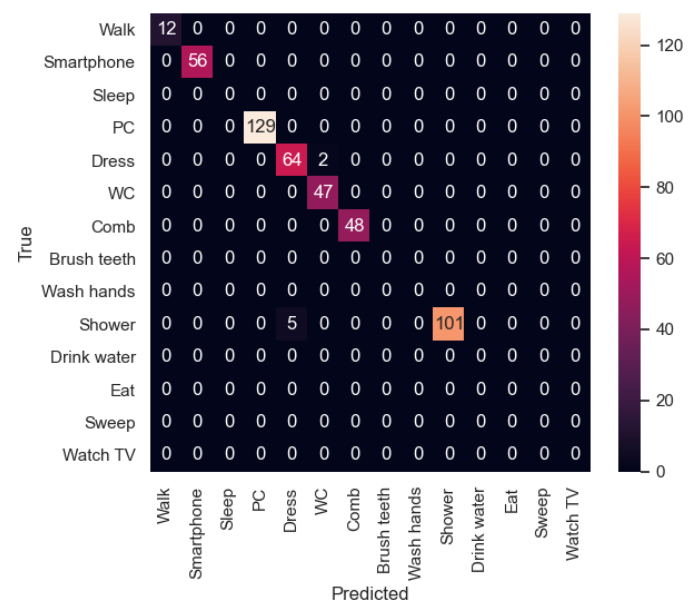
Figure 27. Sequence 3-Experiment 1-Confusion Matrix.